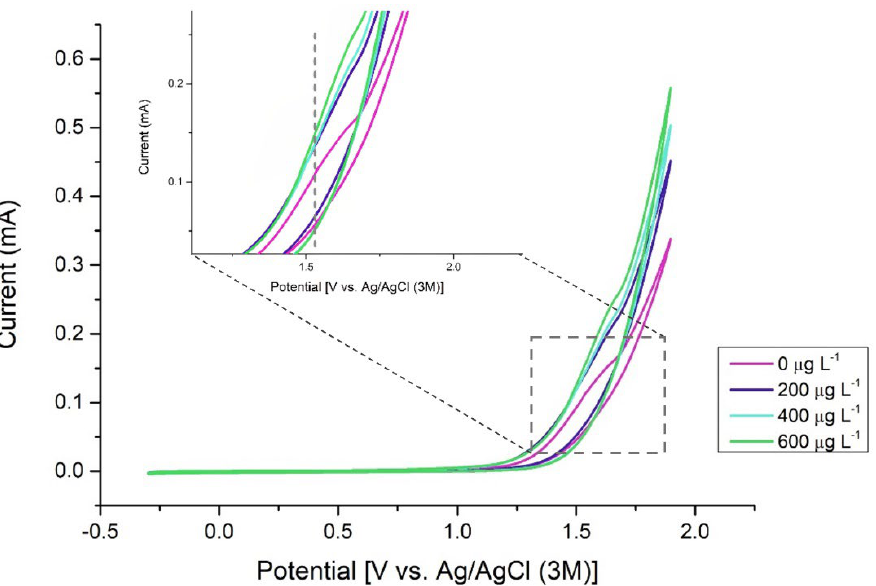
Figure 1. Cyclic voltammogram using a glassy carbon electrode at different MTU concentrations (Scan rate = 50 mV s − 1 ). PBS:MeOH 1:1.